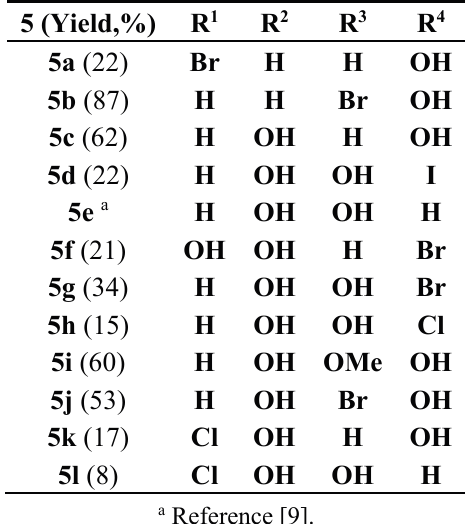
Table 2. 3,4-Dihydroisoquinoline-3-carboxylic acid